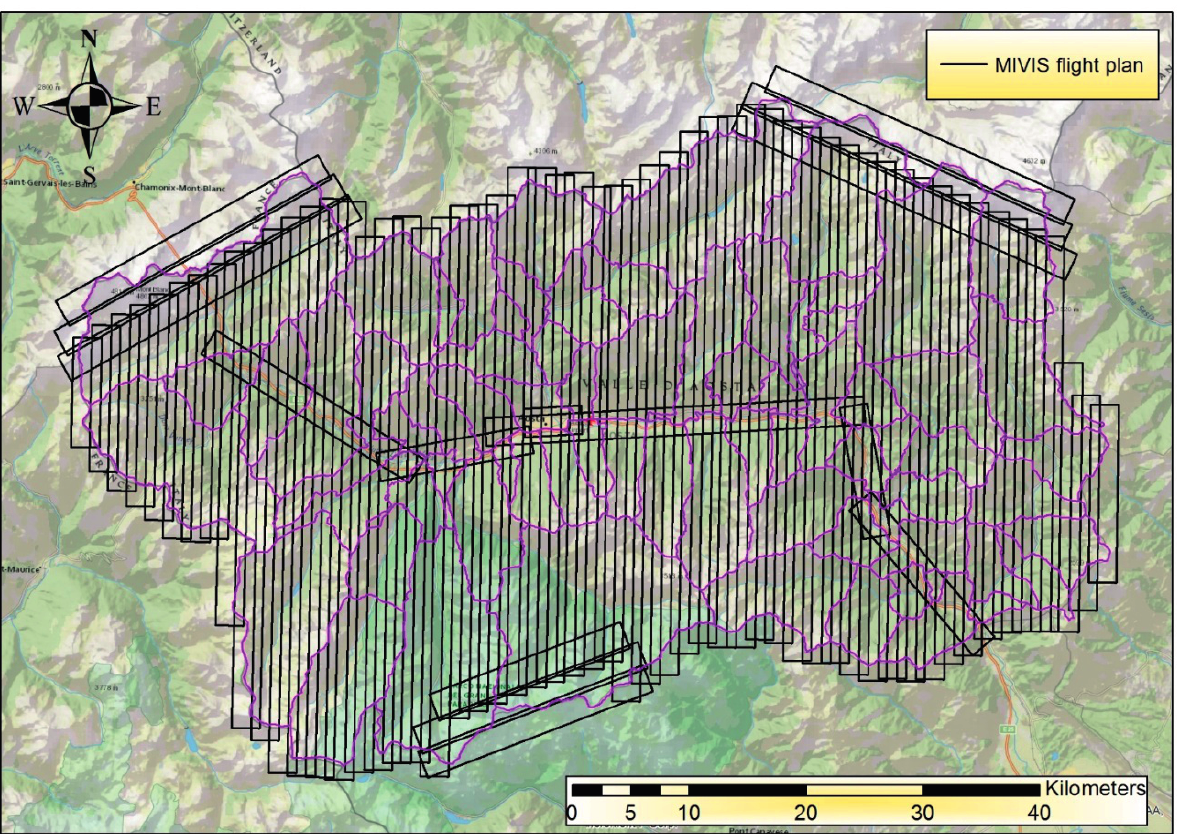
Figure 2. Flight plan of the aerial survey over the of the Valle d’Aosta Autonomous